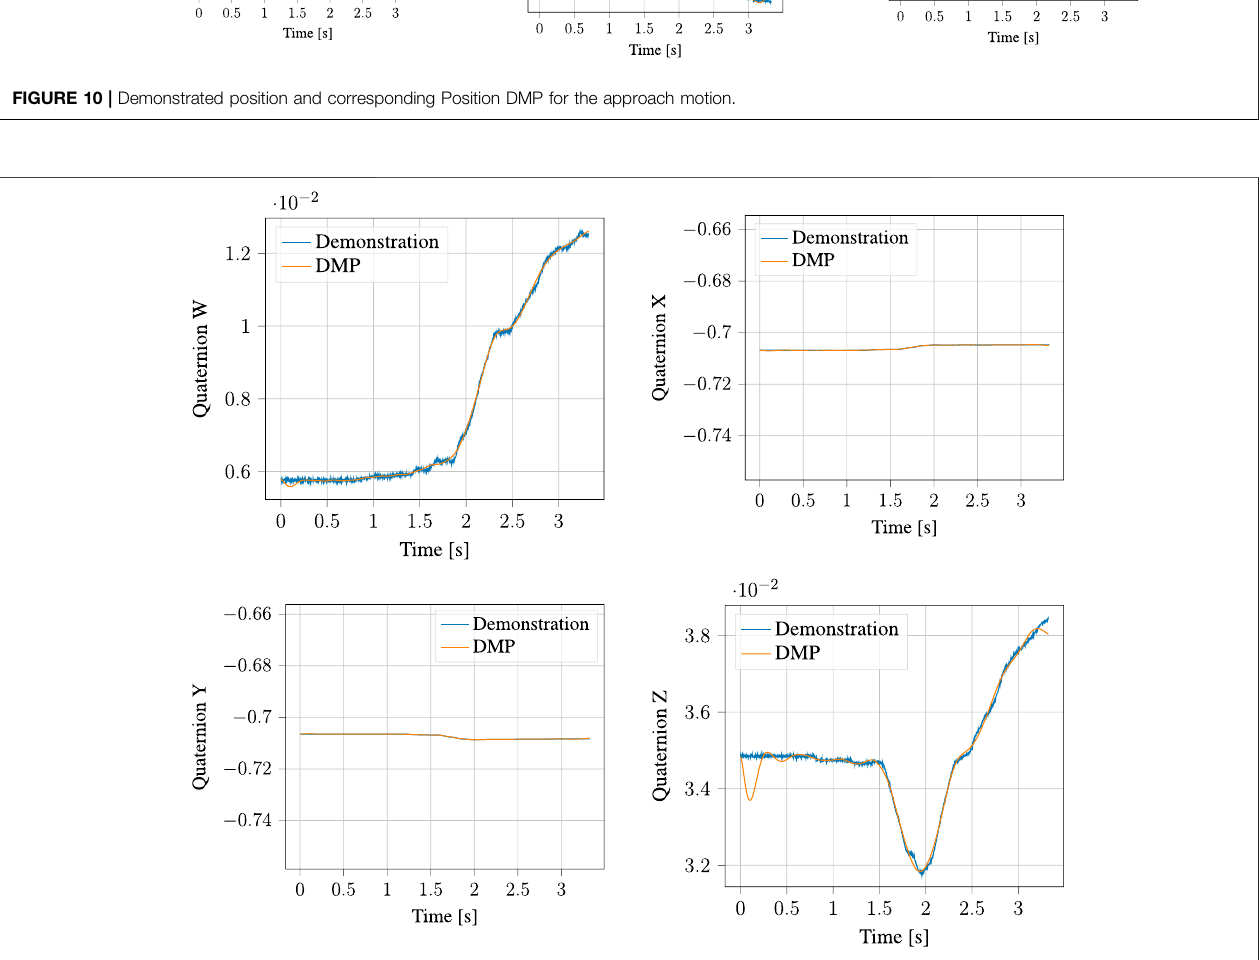
FIGURE 11 | Demonstrated orientation (quaternion) and corresponding Quaternion DMP for the approach motion.